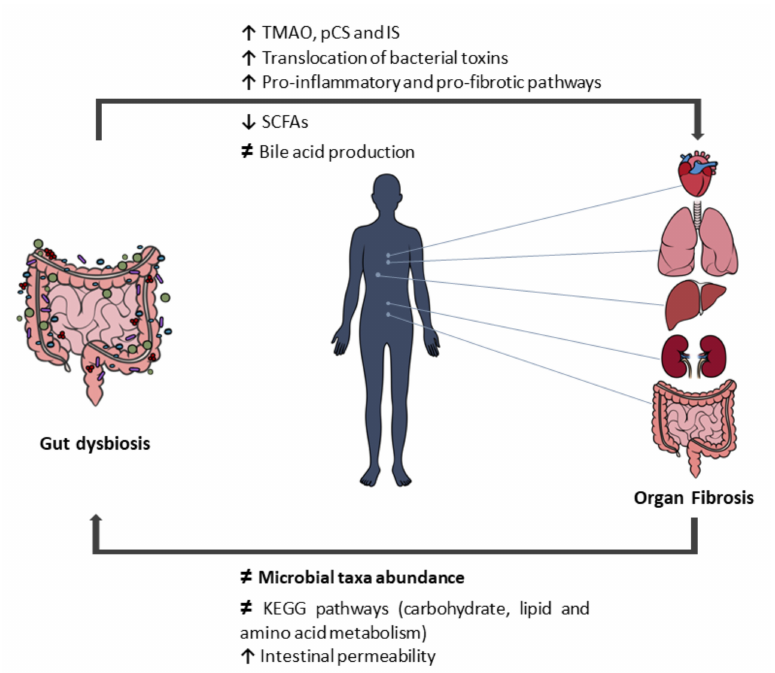
Figure 1. Gut dysbiosis and organ fibrosis. TMAO, trimethylamine N-oxide; pCS, p-cresyl sulfate; IS, indoxyl sulfate; SCFAs, short-chain fatty acids; KEGG, Kyoto Encyclopedia of Genes and Genomes. ↑ increased; ↓ decreased; (cid:54) =